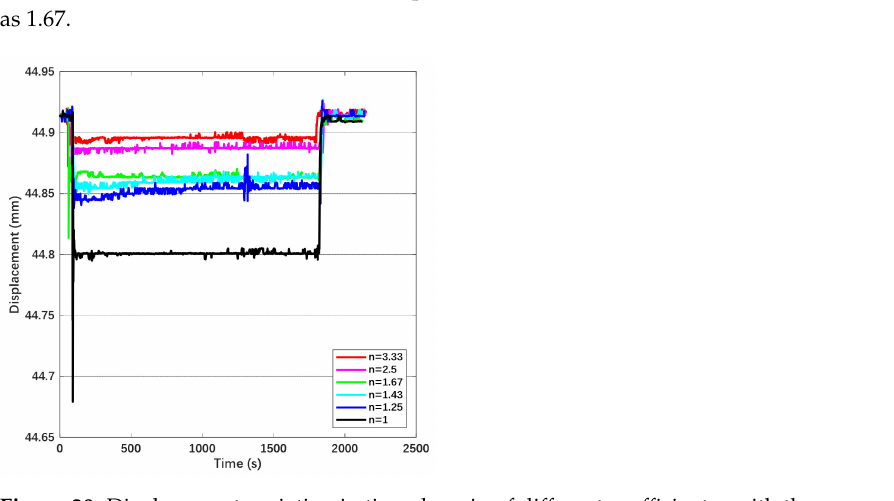
Figure 20. Displacement variation in time domain of different coefficient n with the same amplitude. Table 3. Variation of deposited charge and displacement drift under different